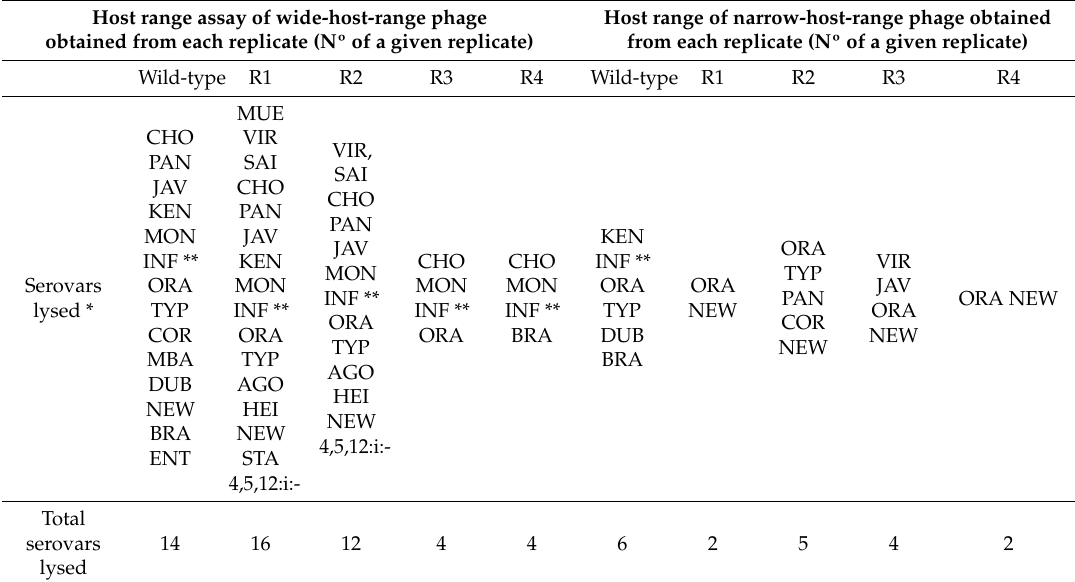
Table 5. Di ff erences in the host range in the four replicates of wide- and narrow-host-range phages obtained at 12 h of the selective challenge